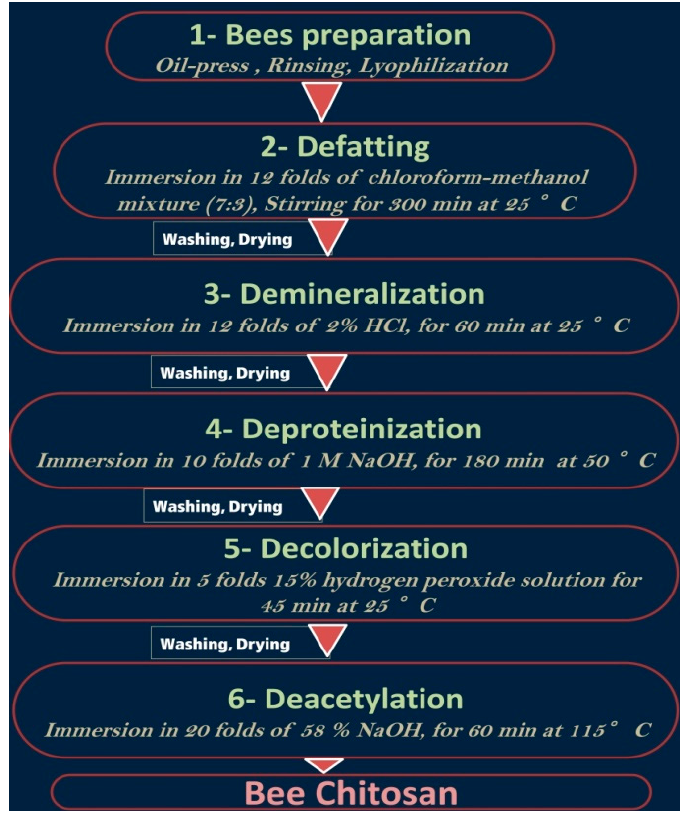
Figure 1. The applied protocol for bees’ chitosan extraction. For achieving bee chitosan extraction, nanoparticles (BCht) and solutions of Na- tripolyphosphate (NTPP; Sigma-Aldrich, MO, USA) with a 0.5% concentration ( w / v ) in DW and chitosan with a 0.1% concentration ( w / v ) in diluted acetic acid (1% concentration) were prepared and filtered, and their pH was adjusted to 5.3. In total, 20 mL of the NTPP solution was slowly dropped (via syringe needle at 350 µ L/min rate) into 100 mL of the chitosan solution and was vigorously stirred throughout synthesis (725 × g ); the stirring continued after NTPP dropping for a further 100 min. The formed BCht was harvested via centrifugation (10,300 × g for 32 min), washed with DW, re-centrifuged and lyophilized